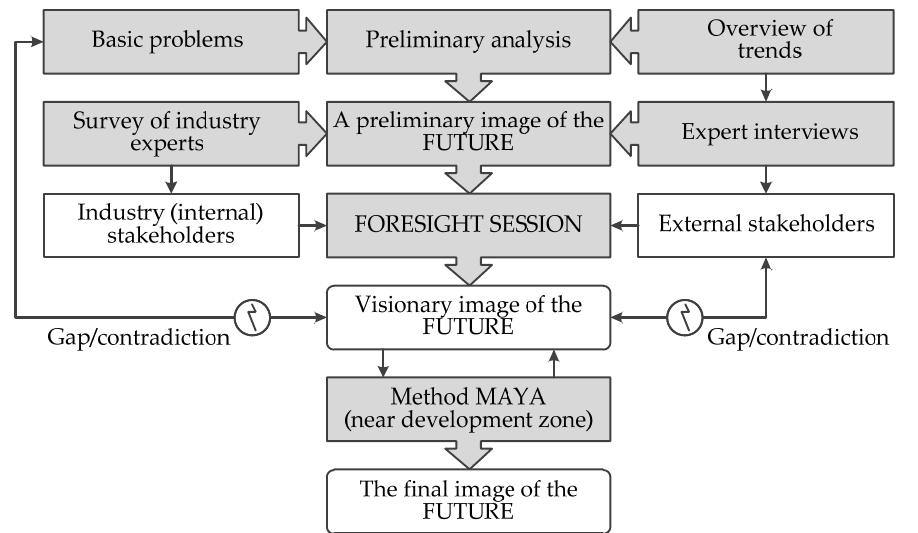
Figure 6. Algorithm of oil and gas industry foresight in Kazakhstan. Table 1. Assessment of the problems of the oil and gas industry of